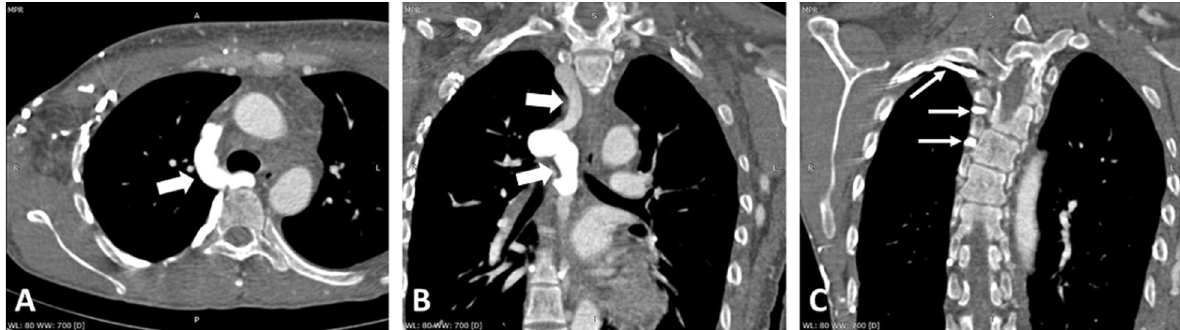
Fig. 3 First-pass phase of CT Thorax in axial and coronal view showing the dilated collateral veins, namely the azygos veins (thick white arrows) and the right superior intercostal veins (thin white arrows)